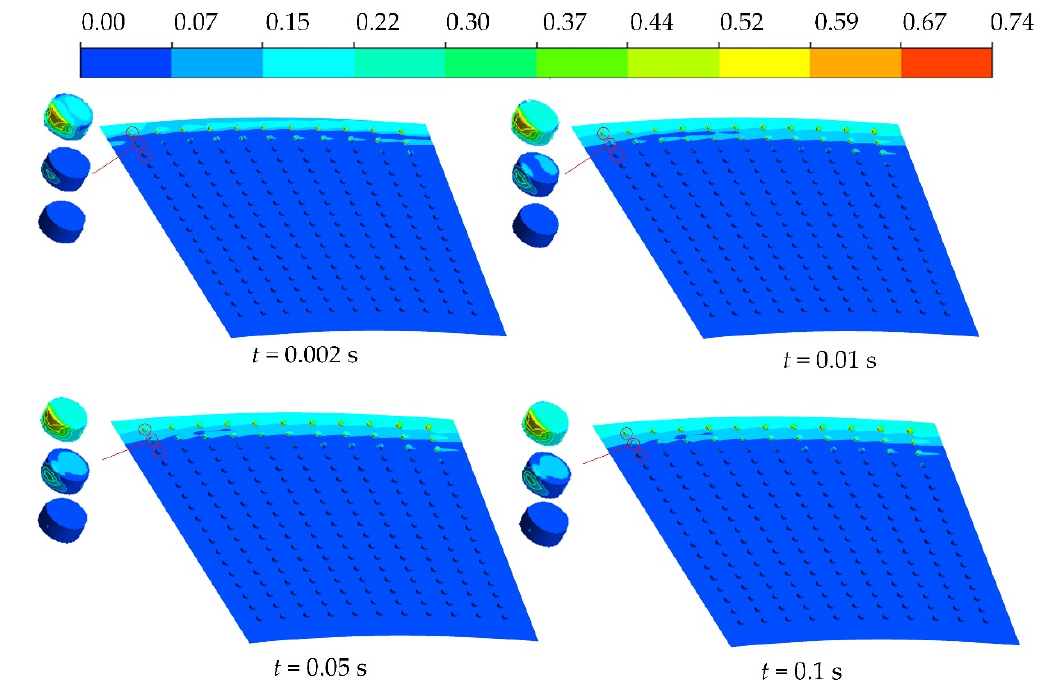
Figure 11. Cavitation morphology evolution when texture rate is 6.41%.